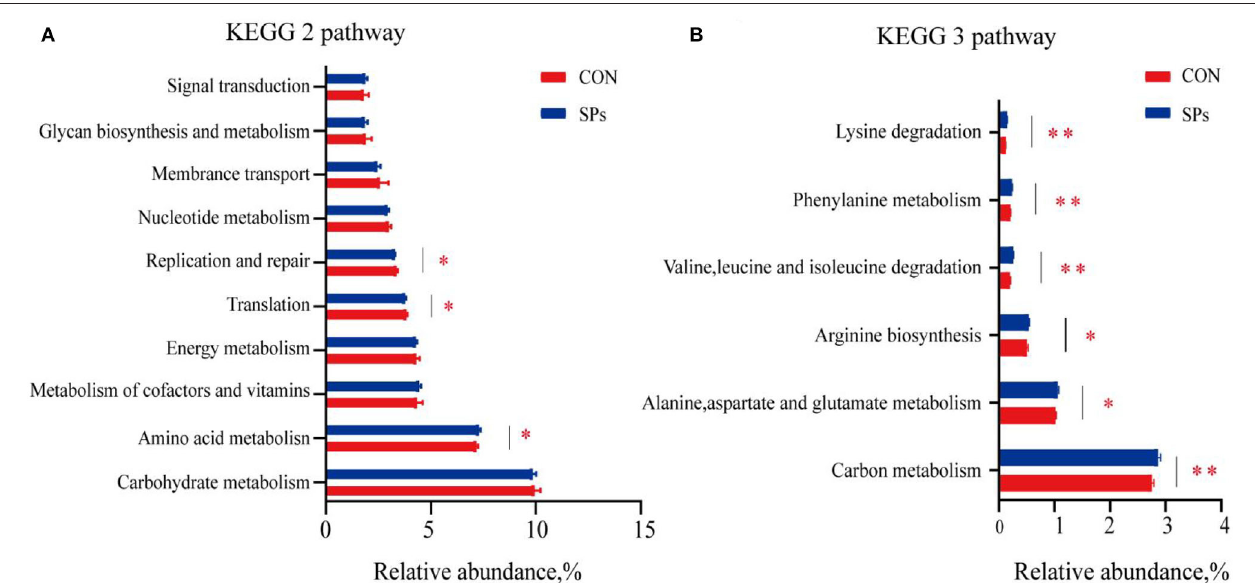
FIGURE 6 | Predicted bacterial functions using PICRUSt analysis in CON and SP groups. (A) KEGG level 2 pathways. (B) KEGG level 3 pathways of “Global and overview maps” and “Amino acid metabolism” in the two groups. *, significant differences ( p < 0.05); **, highly significant differences ( p < 0.01). CON, the control group with no soybean peptide supplementation; SPs, the group with 50 g/head/day of soybean peptide